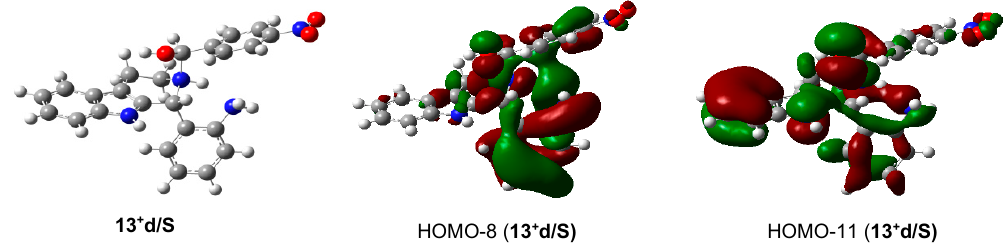
Figure 3. Optimized structure 13 + d / S and its selected MO’s involved in intramolecular interactions contributing to the stability of this cationic intermediate.